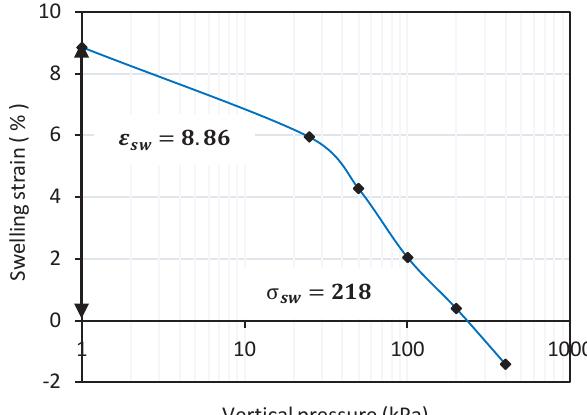
Figure 3: Swelling strain versus vertical pressure Figure 4: Scheme of stresses distributions in the soil below a shallow foundation